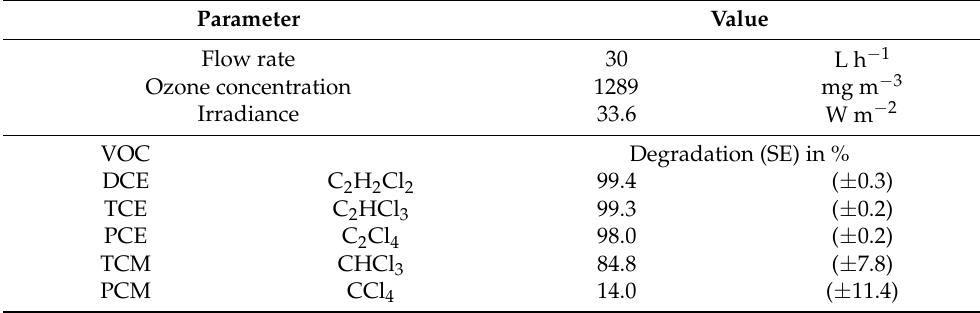
Table 2. Optimized parameters for chlorinated VOCs degradation. Reproduced with permission from ref. [57]. Copyright 2022 Elsevier.